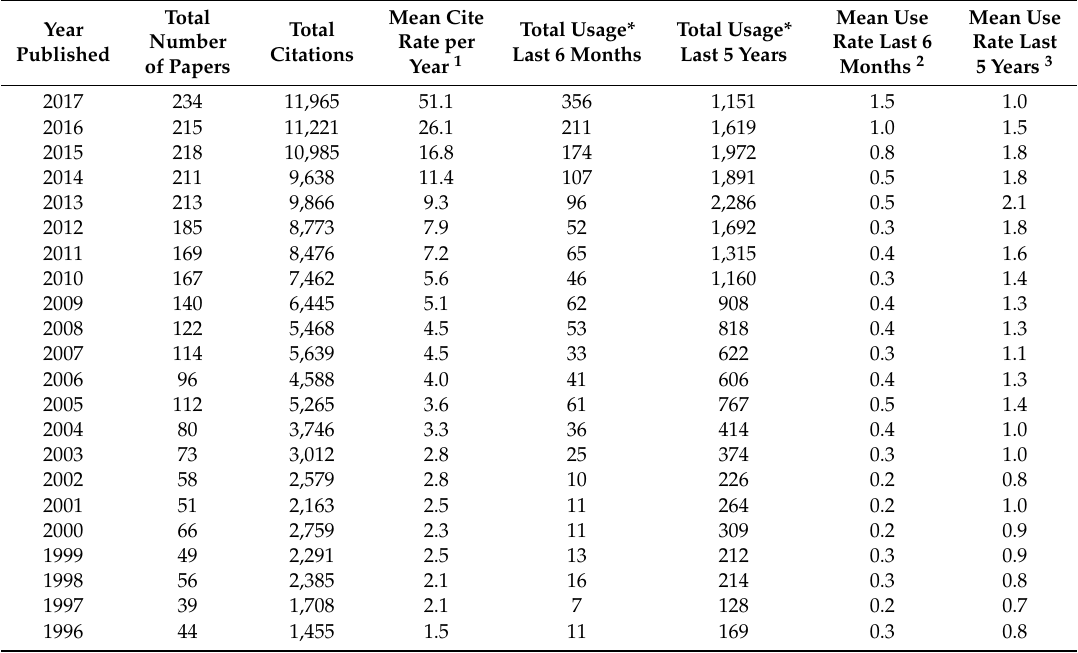
Table 2 indicates the frequency of countries by counting such study settings in the mentioned abstracts. In the top 10, except countries with the highest HIV prevalence, such as South Africa, the number of studies were mostly produced in upper-middle-income and high-income countries (United States, Brazil, China, Canada, Thailand, England, Australia) [33]. The low and middle-income countries such as Botswana, Zambia, Lesotho, Swaziland had below 10 papers, even though these countries have been reported as having the highest rate of HIV / AIDS [34]. Figure 1 displays the global network between 102 countries having co-authorships of selected papers. These countries have been classified into 10 clusters of at least five countries, depending on their level of international collaboration. Cluster 1 (red) refers to the network of countries in the two regions: South-East Asia and the Western Pacific. Cluster 2 (purple) indicates the link of the USA with European countries and Saudi Arabia. Cluster 3 (blue) illustrates international collaborations between the Americas, South Africa, and some countries in Asia. Cluster 4 (brown and green) demonstrates the co-authorship between countries within Southeast Africa. In addition, they have an additional link with England. The European countries tend to associate with each other by geographical areas, such as orange, pink, light blue, and yellow (French West